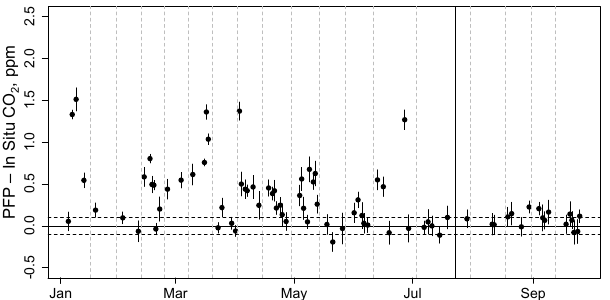
Fig. E2. PFP flask minus in situ differences at BAO for 2013 corre- sponding to periods when the in situ standard deviation over 5min was < 0.15ppm. The solid black vertical line corresponds to when the new conditioning protocol for PFP sampling was implemented. Dashed gray lines correspond to when PFP units were switched. Error bars show the 5min standard deviation of the in situ